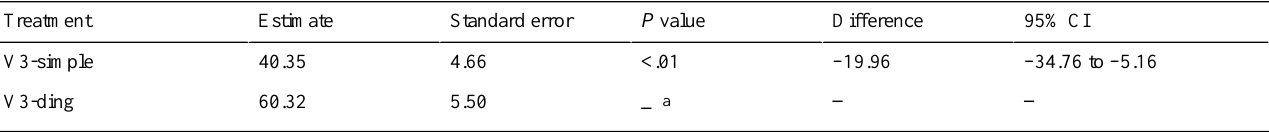
Table 4. Estimated means for response rate adjusted for group and work